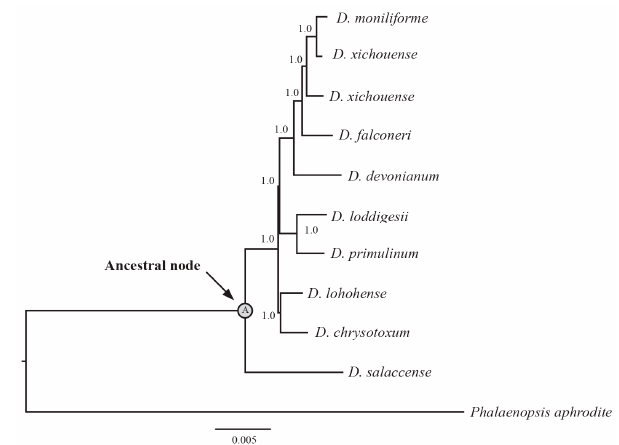
Figure 3. The BI tree inferred from whole plastome sequences of Dendrobium species. Tree node labeled with “A” denotes to the ancestor for each Dendrobium species. The values of posterior probabilities are showed for each node.